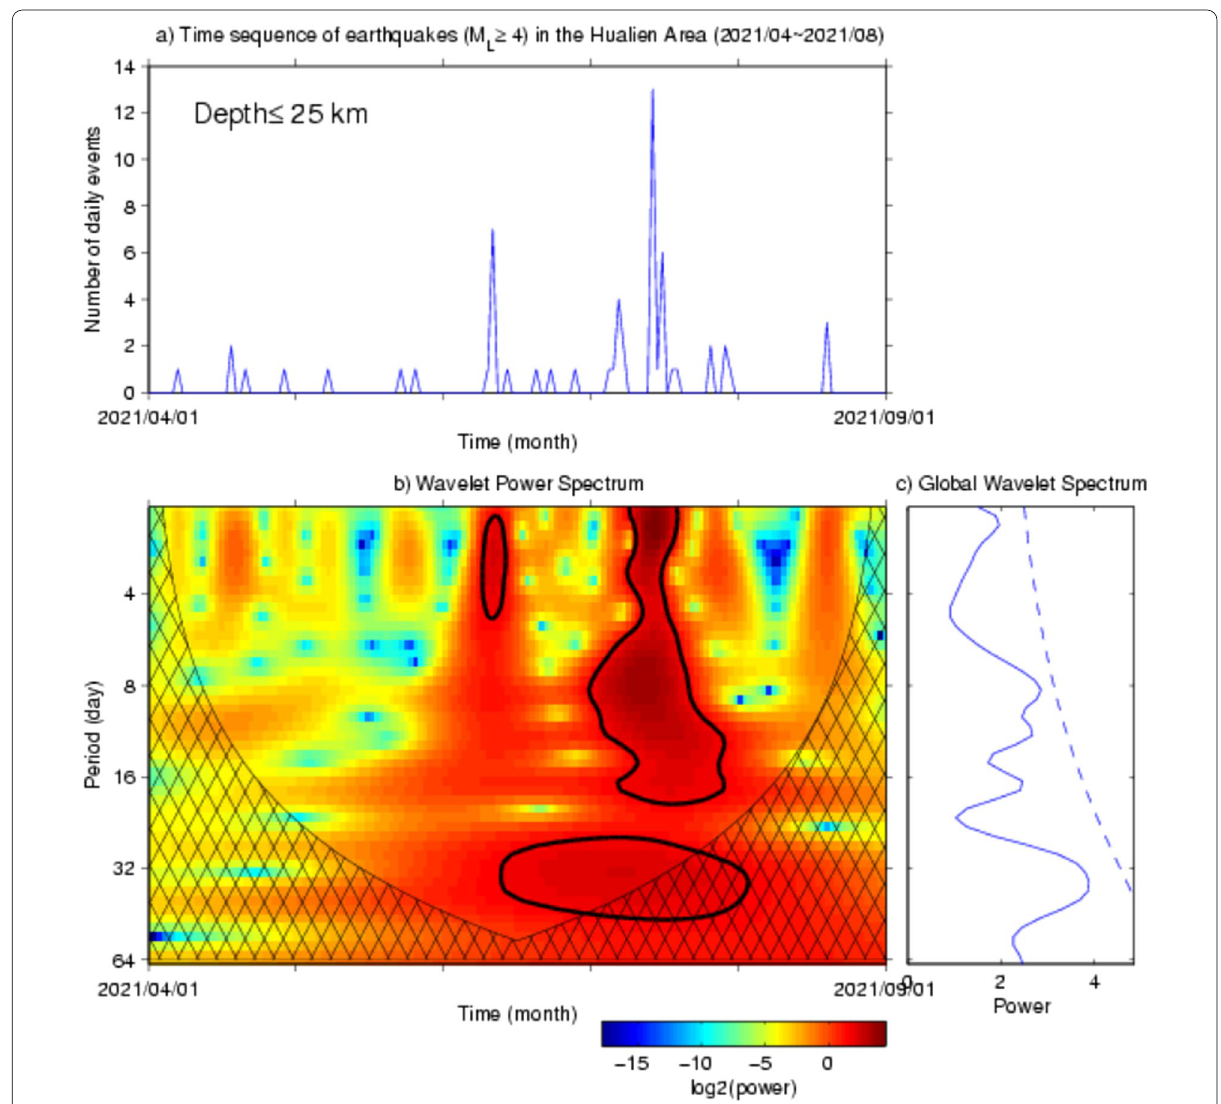
Fig. 6 a for the time sequence of number of daily events with M L 4; b for wavelet power spectrum; and c for the average, or the global wavelet ≥ spectrum, of b over all longitudes. The thick contour is the 95% confidence level, using a white‑noise background spectrum. The black net is described in the text. The dashed line is the 95% confidence level for the global wavelet spectrum, using a white‑noise background